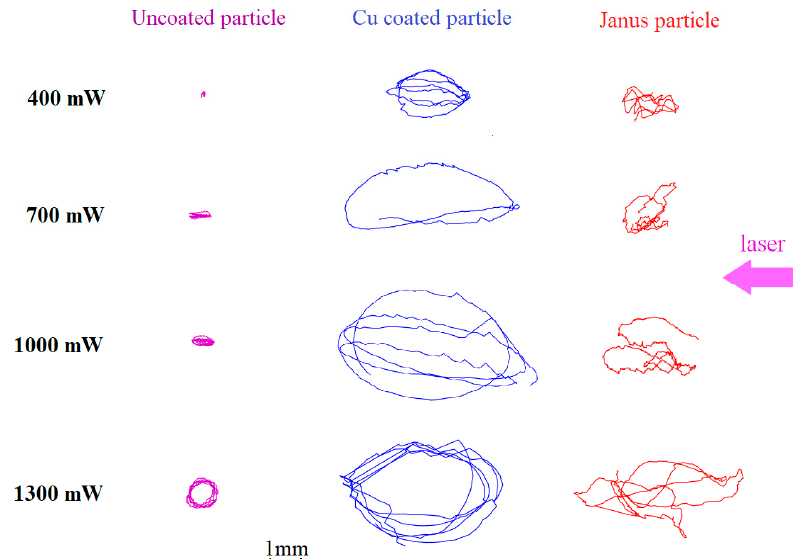
Figure 2. Top View (horizontal component of the active Brownian motion). Dust particle trajectories in the DC discharge stratum during the time ∆ t = 1 s, at different laser powers W las : 400, 700, 1000, and 1300 mW. Left row is uncoated dust particle; the central row is the Cu-coated dust particle; right row is the dust Janus